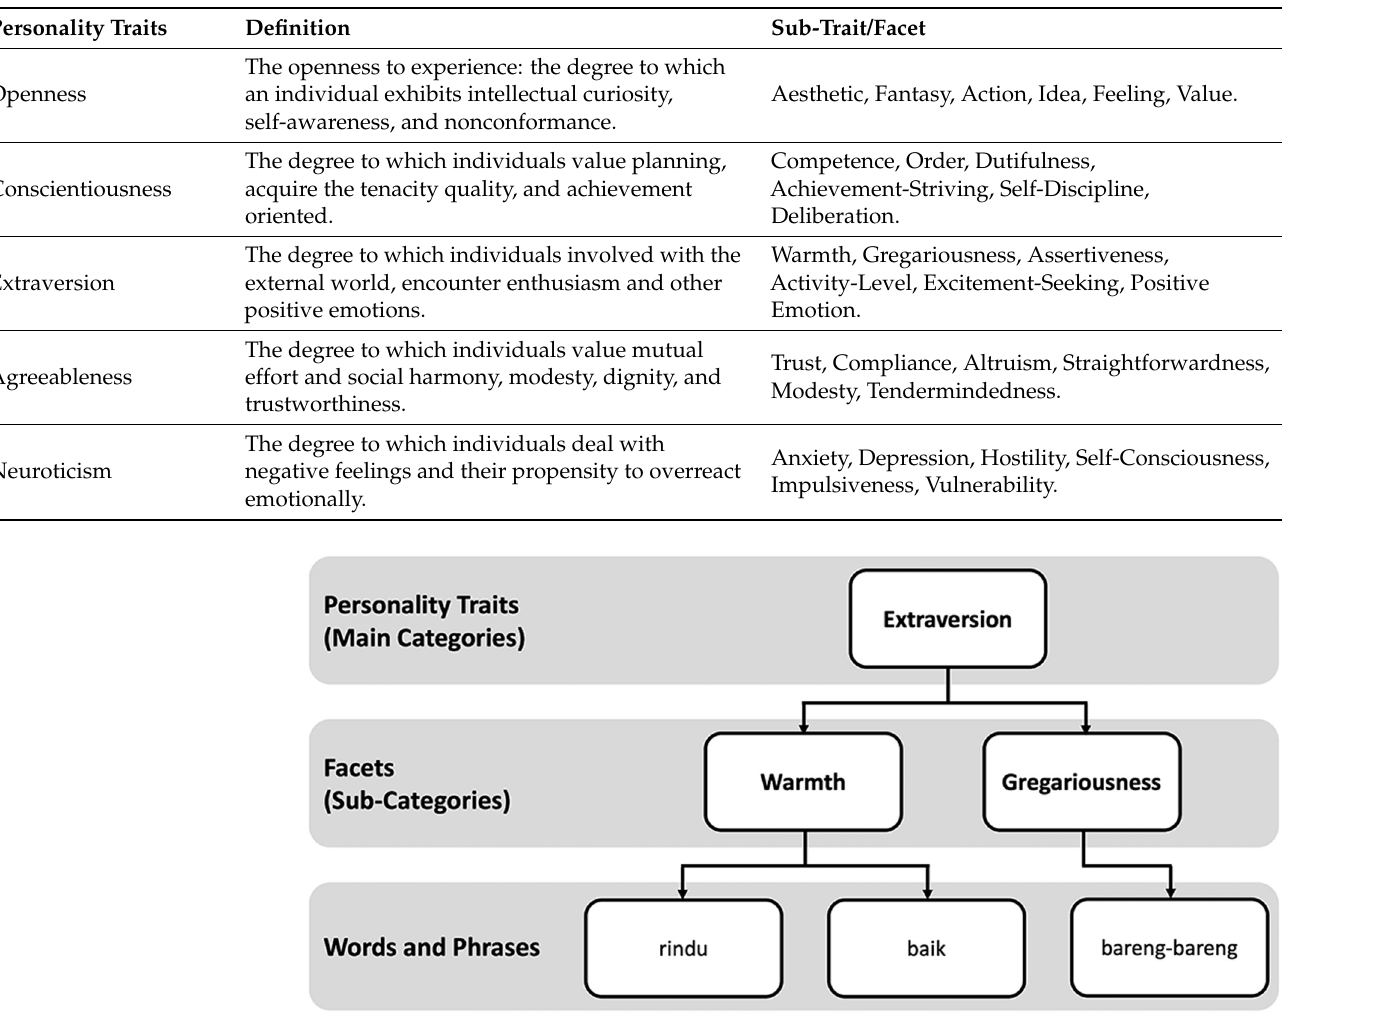
Figure 3. Main Categories and Subcategories in the Ontology Model.